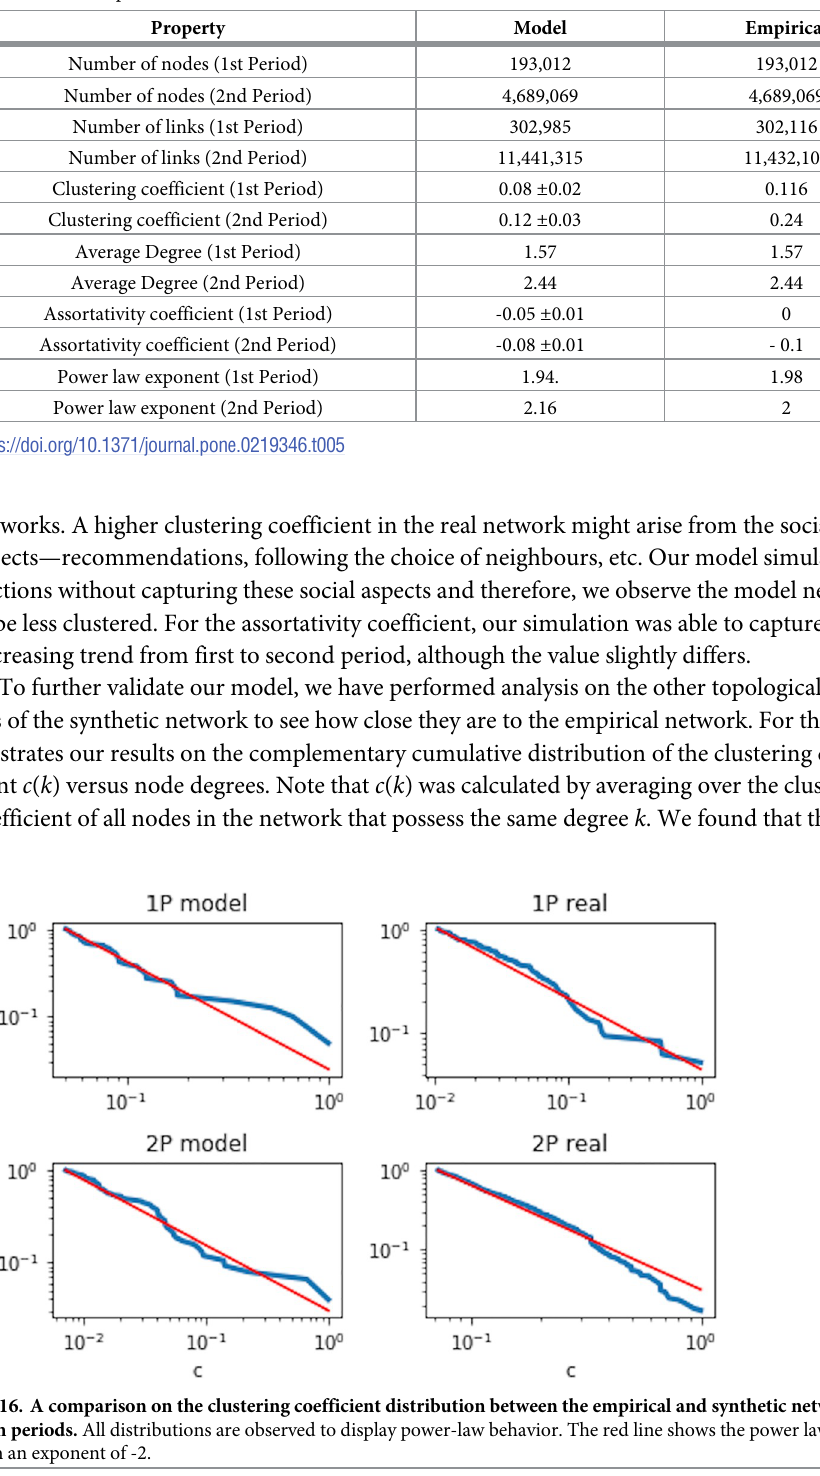
Table 5. A comparison of basic network properties between the synthetic and empirical bitcoin network. We observe that while our model was able to reproduce the scale-free behaviour and diassortativity of the empirical net- work (for the 2 periods), the clustering coefficients still differ. We relate it to the social aspects of the bitcoin system which were not implemented in the current model.